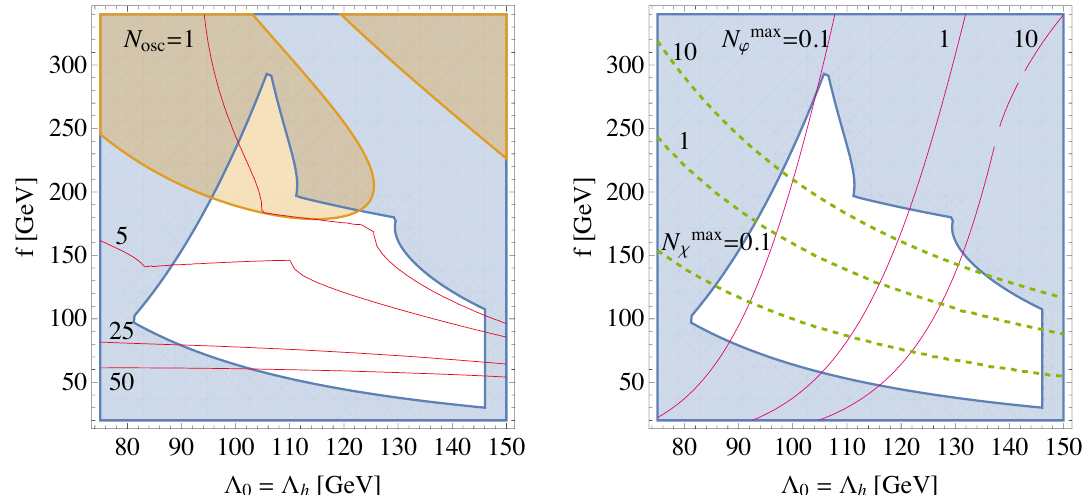
Figure 6 . Consistency check of our analysis. The blue shaded region is a summary of (cid:12)gure 5. Left: the orange shaded region violates eq. (7.13). The red lines show the estimate of the number of Higgs oscillation, N osc = 1 ; 5 ; 25 ; 50. Right: the maximum occupation number produced before the Higgs oscillation. The red solid lines correspond to N max = 0 : 1 ; 1 ; 10 and the green dashed ’ ones correspond to N max = 0 : 1 ; 1 ; 10. (cid:31)